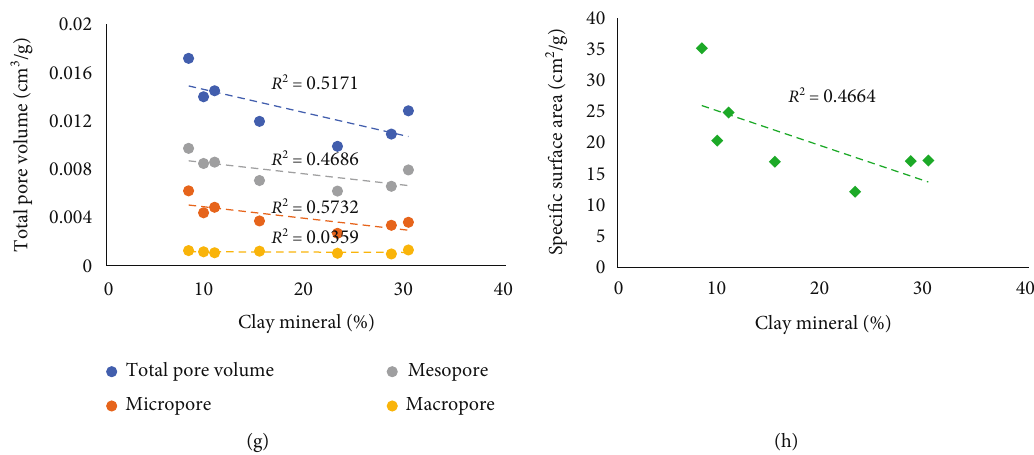
Figure 10: Correlation analysis of reservoir space parameters with organic carbon and mineral